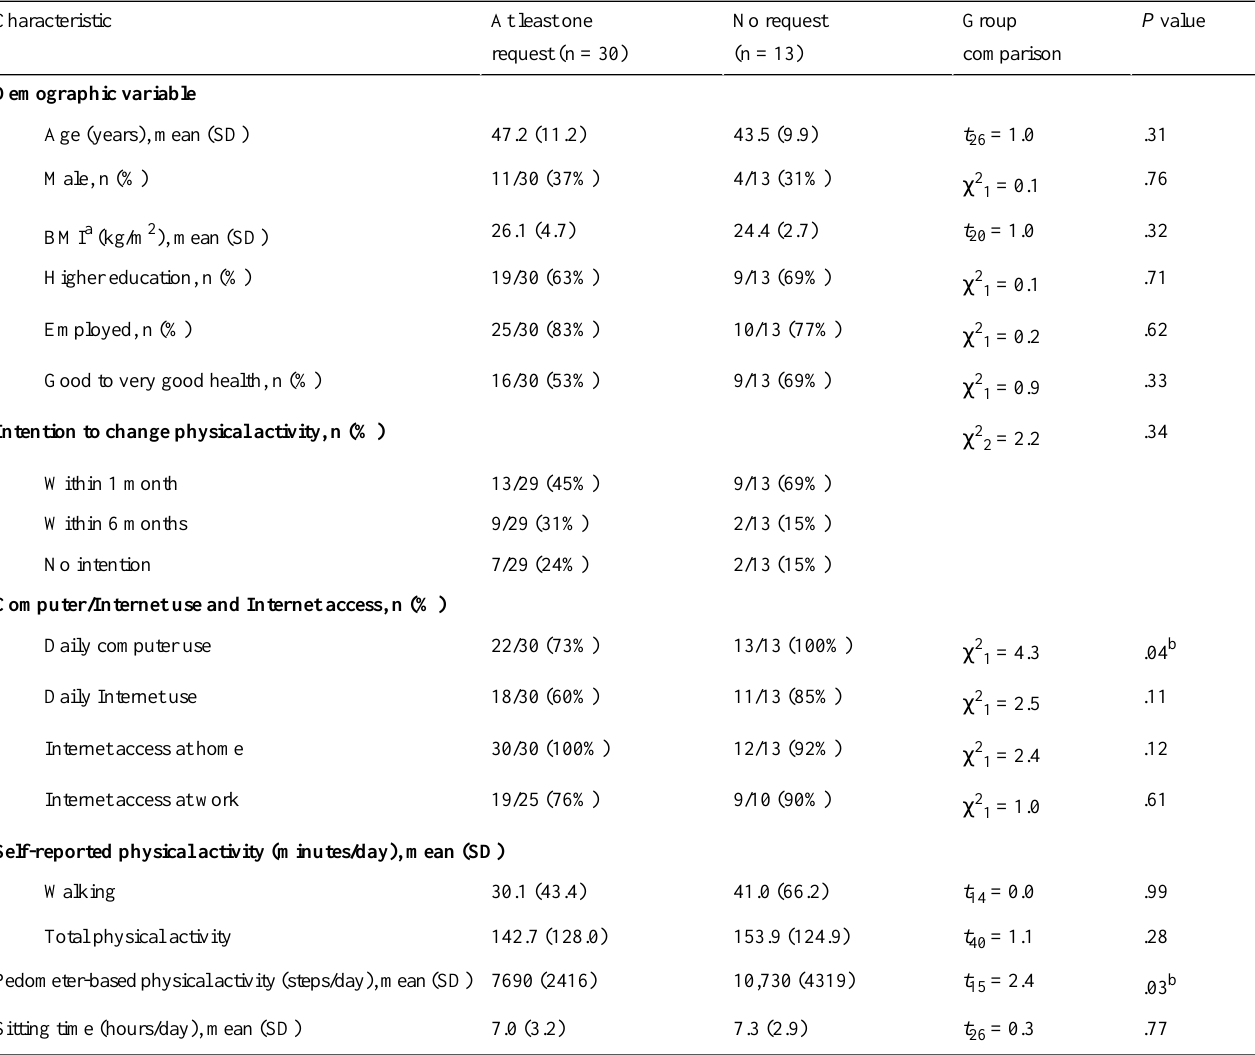
Table 3. Baseline characteristics of the participants in the tailored condition who requested the computer-tailored step advice at least once and those who did not request the computer-tailored step